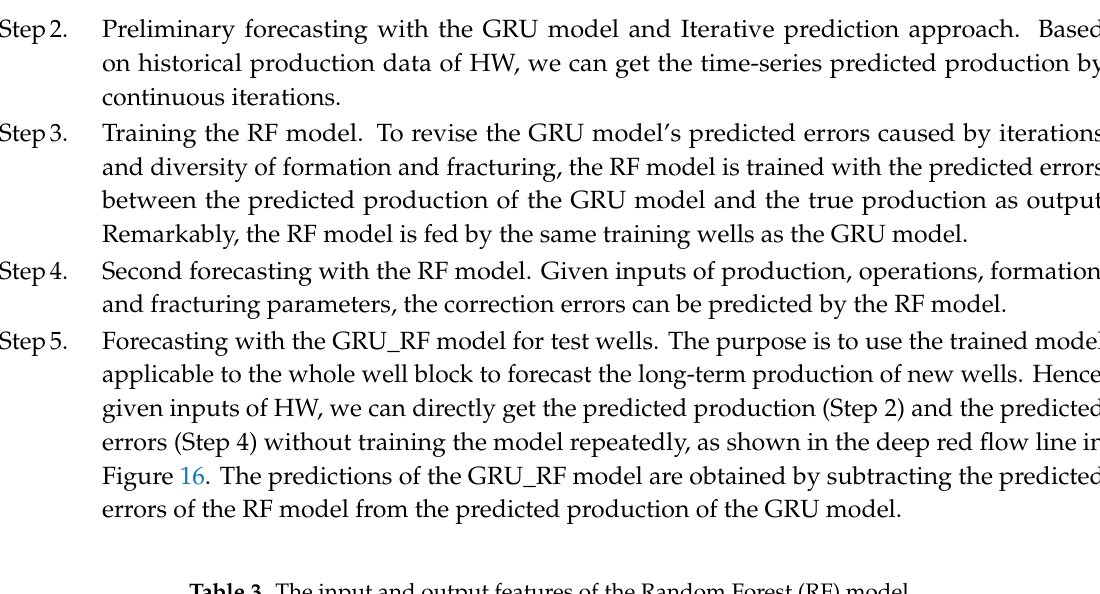
Table 3. The input and output features of the Random Forest (RF)